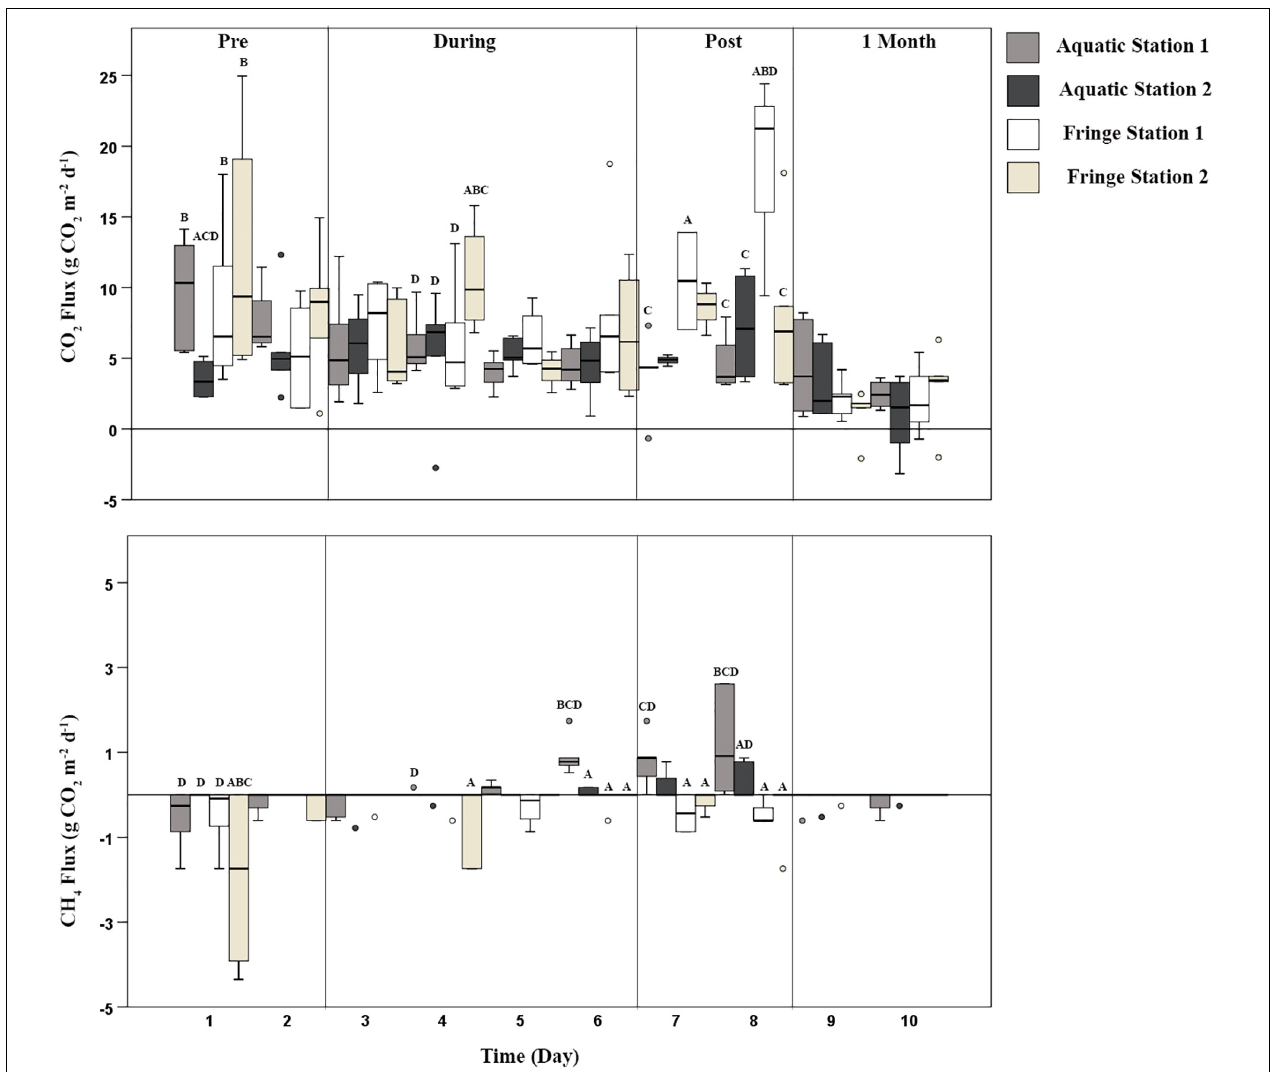
FIGURE 3 | CO 2 (g CO 2 m − 2 day − 1 ) and CH 4 (g CO 2 -e m − 2 day − 1 ) emissions across the entire watering event. Station significantly altered carbon emissions over time. Time represented the calendar day of measurement (pooled day and night sampling periods). Vertical lines within the figure represent divisions between different phases across time. Pre environmental watering occurred during days 1–2, during environmental watering occurred during days 3–6, post environmental watering occurred during days 7–8, and 1 month after water left the wetland, flux measurements were taken for 2 days (shown here as day 9–10). Two stations were nested within each zone; the Aquatic Station 1 (light gray box), Aquatic Station 2 (darker gray box), Fringe Station 1 (white box), and Fringe Station 2 (light brown box). Letters above bars denote significant variation across each station at that specific time. If Aquatic Station 1 (A), Aquatic Station 2 (B), Fringe Station 1 (C), and Fringe Station 2 (D) were significantly different from one another, the letters corresponding with their significant variation were placed above that